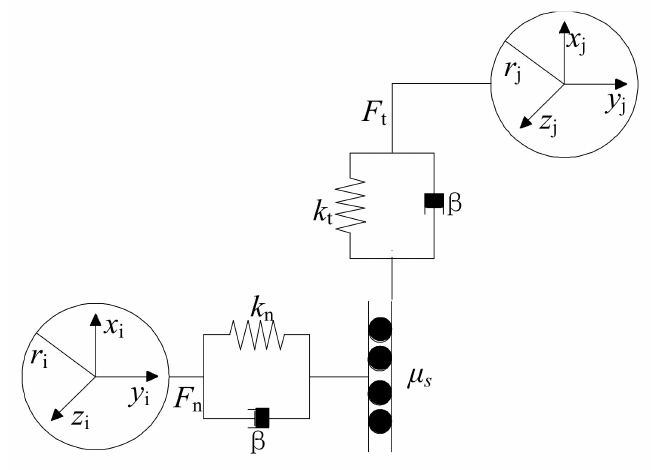
Figure 4. The schematic illustration of the Hertz–Mindlin (no-slip) contact model used in EDEM